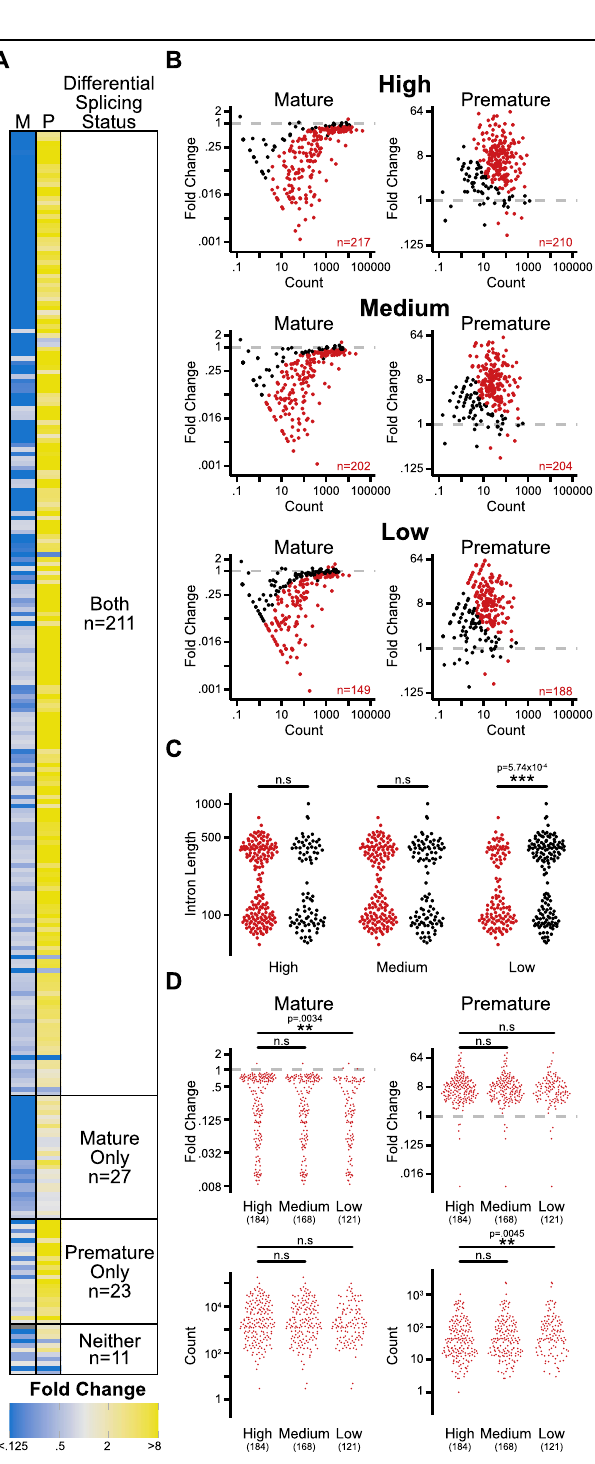
Fig. 1 | Selection bias introduces false correlations at insuf fi cient read